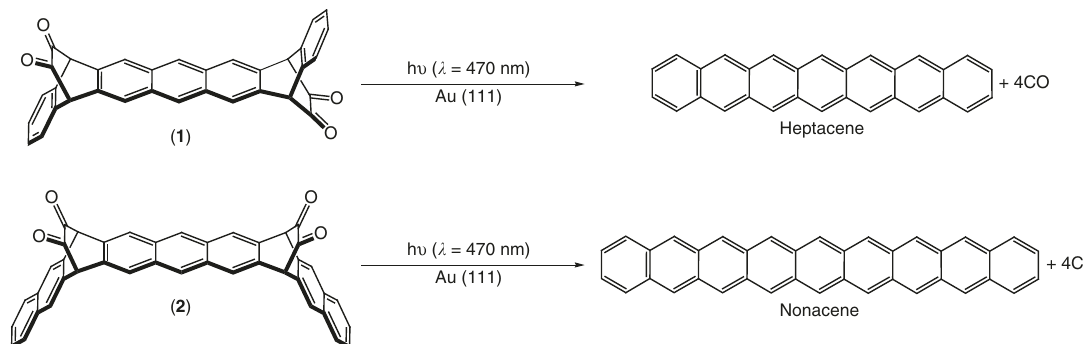
Fig. 1 Light-induced on-surface formation of heptacene and nonacene. Schematic representation of the photodissociation of α -bisdiketone protected heptacene ( 1 , top panel) and nonacene ( 2 , bottom panel) precursors on a Au(111) surface to give rise to the formation of heptacene and